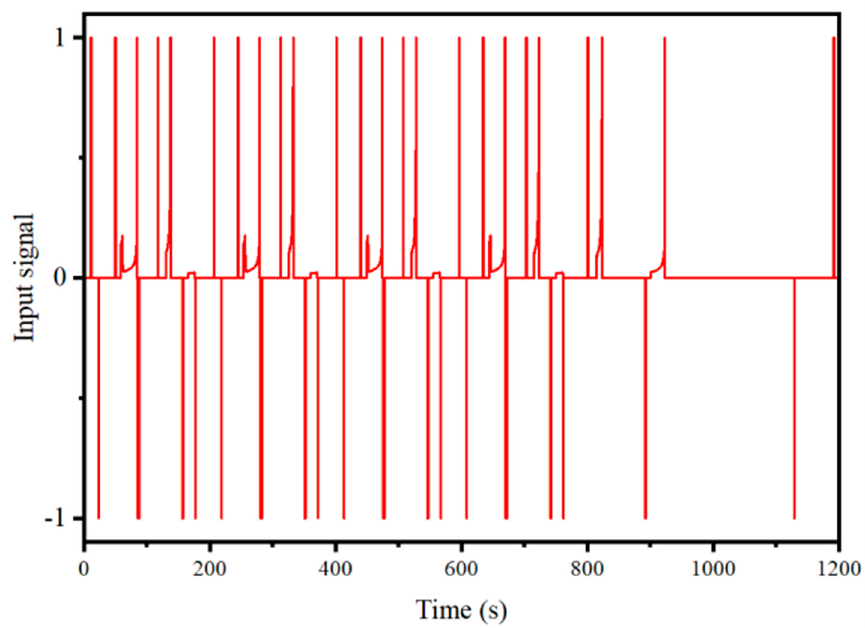
Figure 15. Diagram of the speed and pressure curves .